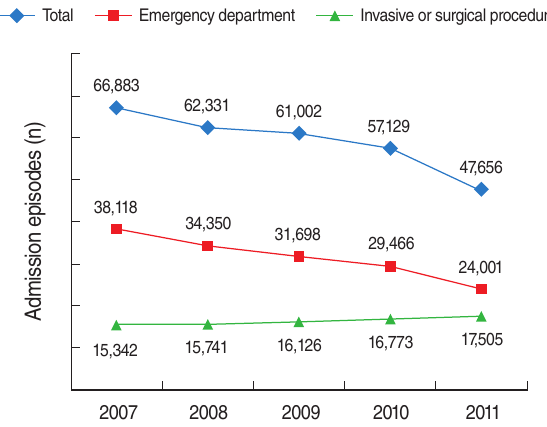
Figure 2. Quantity of total admissions for acute myocardial infarc­ tion, admissions through the emergency department, and admis­ sions involving invasive or surgical procedures over time.